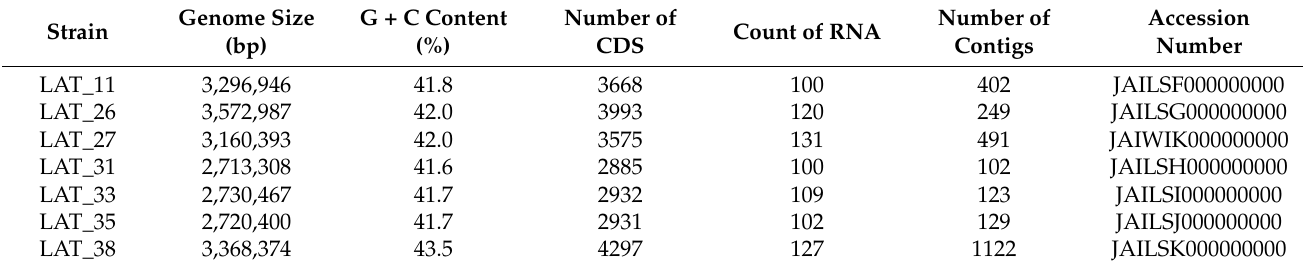
Table 2. General genomic features of Anoxybacillus strains analyzed in the present study.